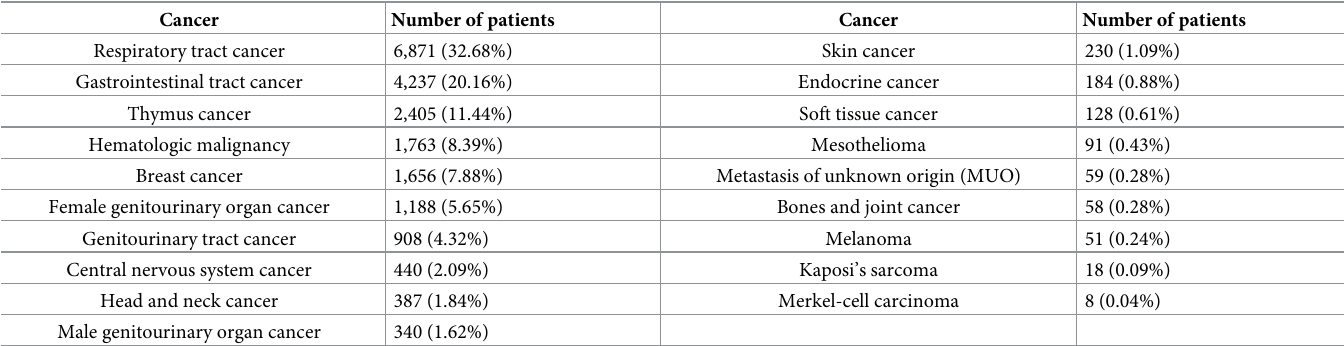
Table 2. Distribution of patients by cancer type.